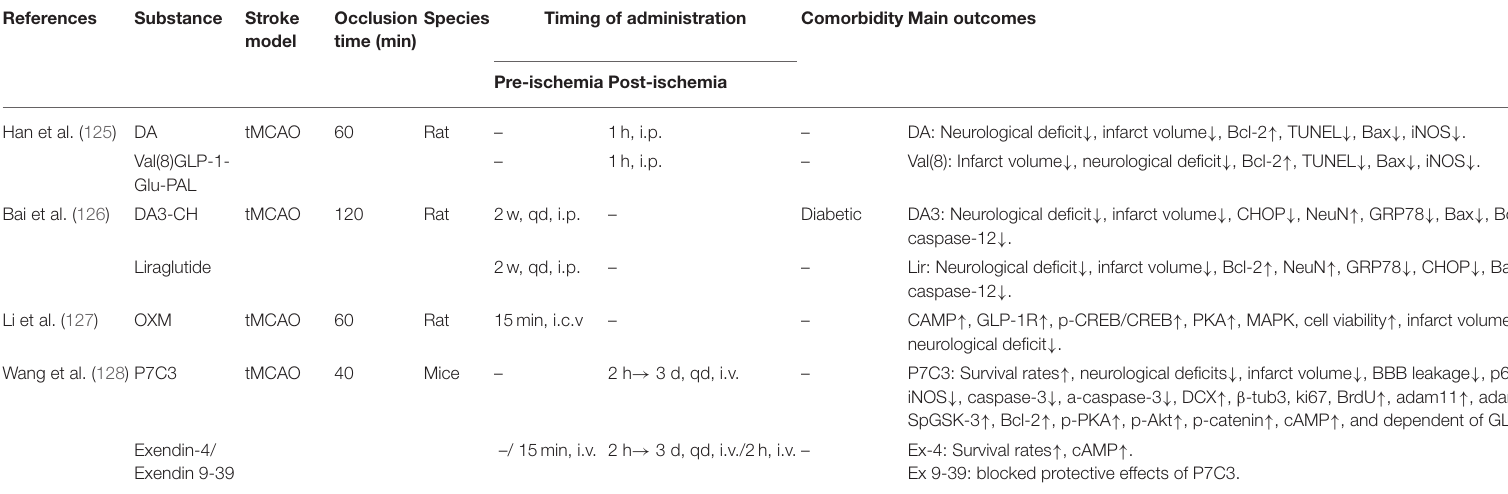
TABLE 2H | A review of preclinical studies of GLP-1 and GLP-1RAs in